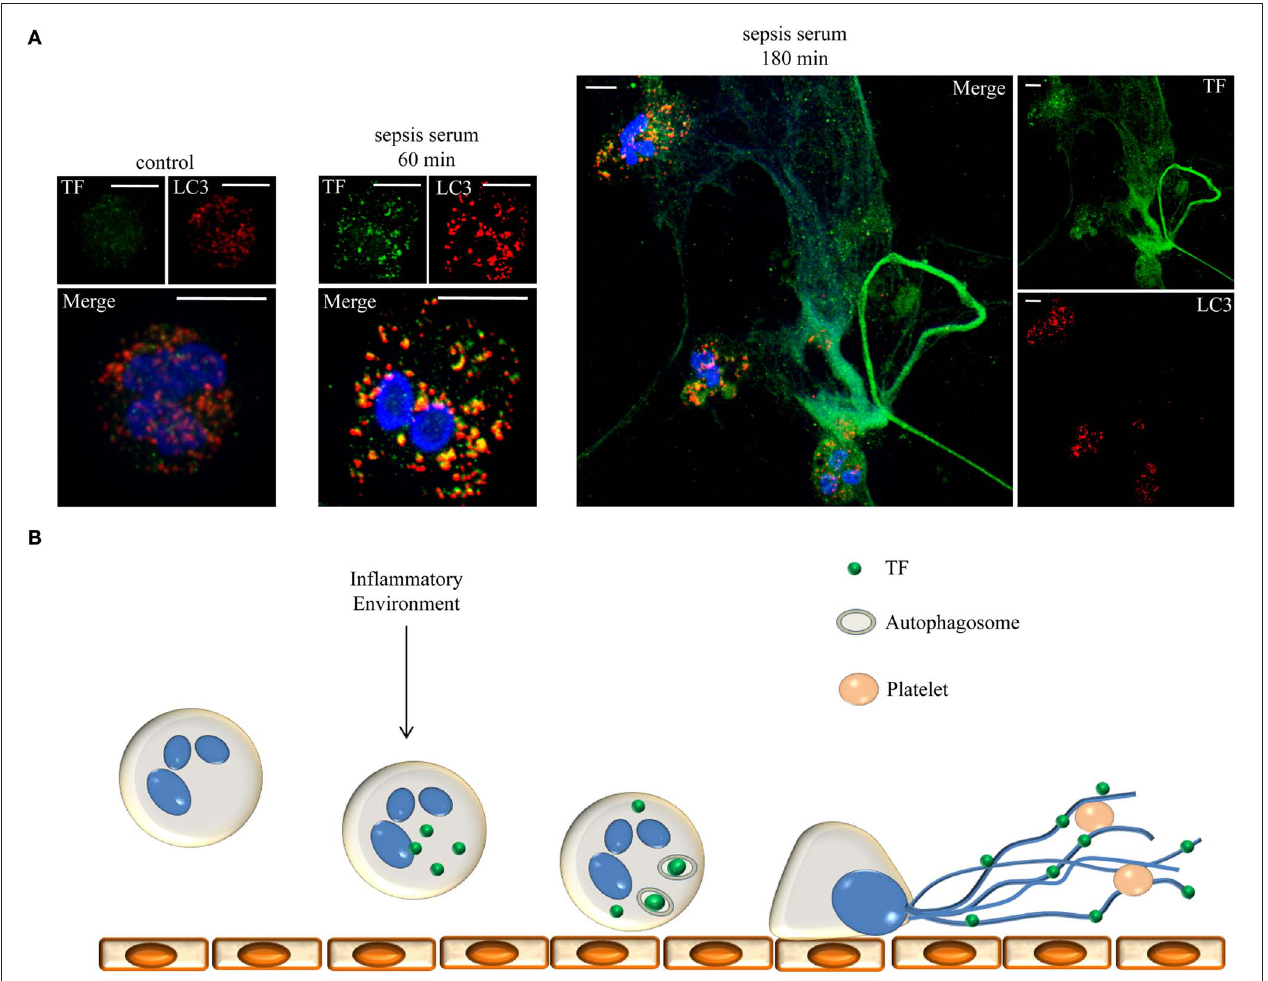
FIGURE 1 | Neutrophils release NETs decorated with TF under sepsis conditions. (A) Neutrophils were incubated for 60 or 180min with serum from patients with sepsis to release NETs. TF (green staining) is localized in autophagosomes (LC3B: red staining) and in NETs, respectively. DNA stained with DAPI (blue). Z-stack analysis. Scale bars represent 5 μ M. Original